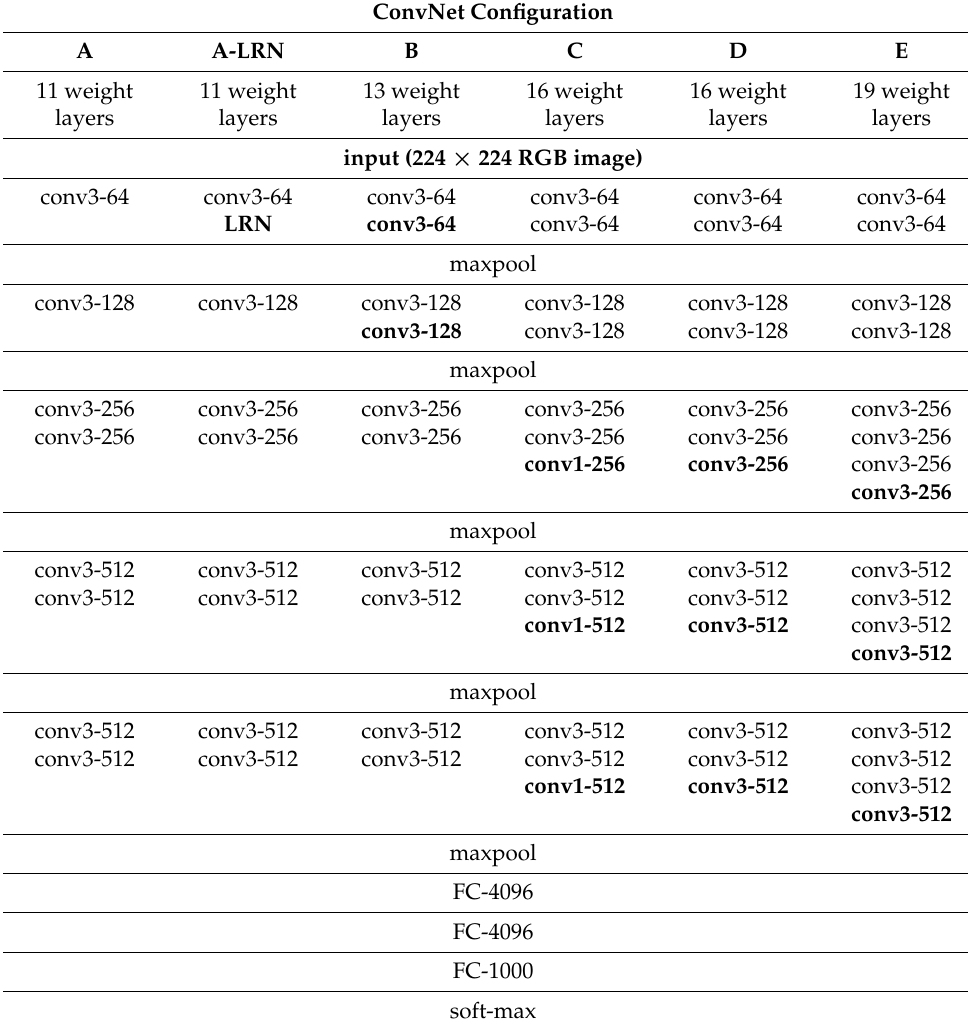
Table 2. VGG recreation, based on the original image found in